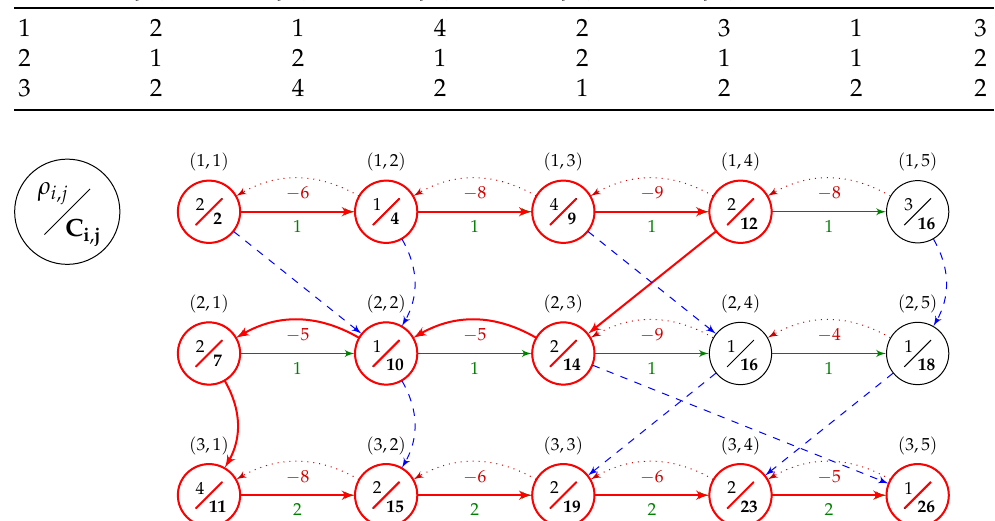
Figure 3. Solution graph for the instance from Example 2 and π = (( 1,2,3,4,5 ) , ( 2,1,4,3,5 ) , ( 2,1,3,5,4 )) .